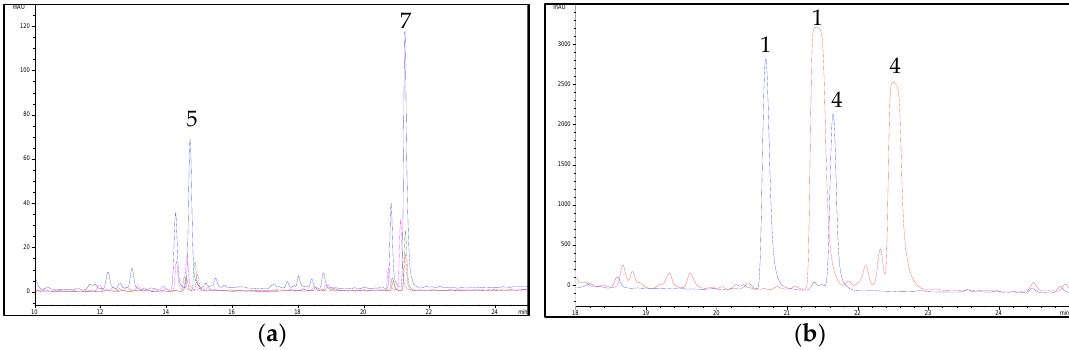
Figure 5. ( a ) Effect of different pre-maceration procedures on flavonoid extraction from hemp (sample C6). Chromatograms obtained at 342 nm with pre-maceration with n- hexane (3x) (blue line), with n- hexane (2x) + dichloromethane (DCM) (1x) (red line), with n- hexane (2x) + ethyl ether (1x) (green line), with n- hexane (2x) + toluene (1x) (pink line). For peak numbering, see Table 1. ( b ) Effect of pre-maceration with n -hexane on cannabinoid removal from hemp (sample C6). Chromatograms obtained at 210 nm with pre-maceration with n -hexane (3x) (blue line) and without pre-maceration (red line). For peak numbering, see Table 1.